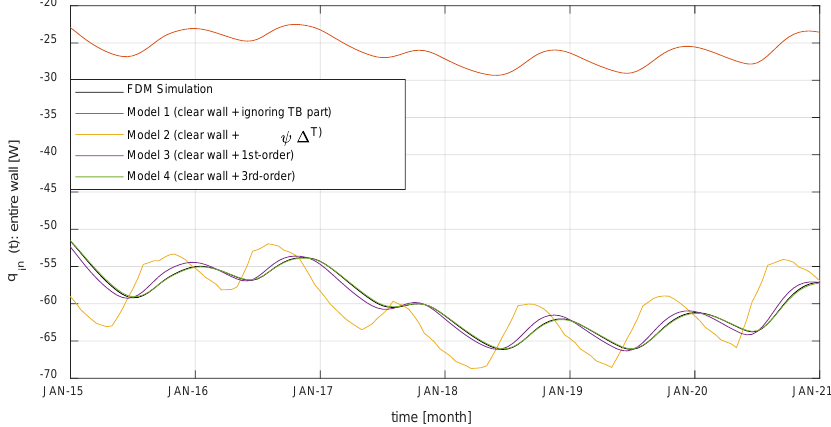
Figure 15. Heat flow through the entire wall (Winter).